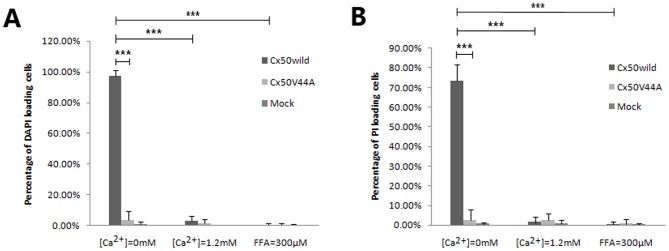
PI dye uptake in HeLa cells stably transfected with Cx50WILD and Cx50V44A.The PI dye uptake assay revealed similar results as the DAPI dye uptake assay. The three pictures in the last line show the Cx50 protein, PI-stained nuclei (nucleoli)/cytoplasm, and merged look of the wild-type cells in Ca2+-free HBSS. Scale bar: 20 µm.